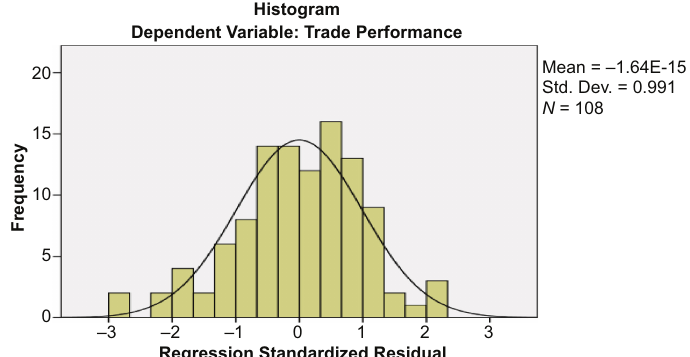
Figure 1. Graphical